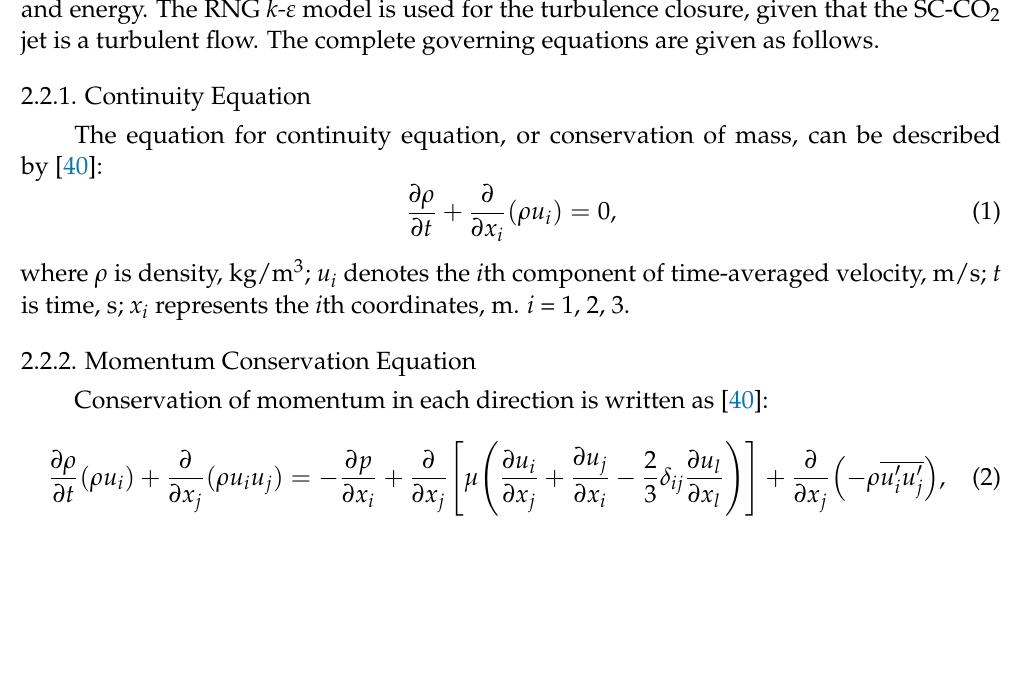
Figure 2. Three-dimensional geometric model for the simulation of the swirling-round SC-CO 2 jet flow field: ( a ) meshing of the flow region; ( b ) amplification of meshing at the rotating impeller and central channel.